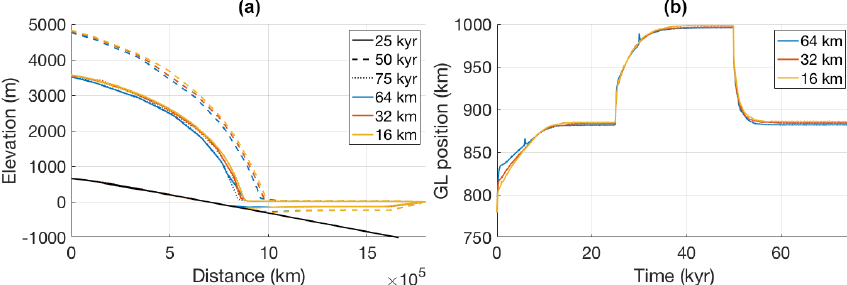
Figure 10. (a) Cross sections of the modelled ice sheet at different times and different resolutions. (b) Grounding-line position over time for the different resolutions.